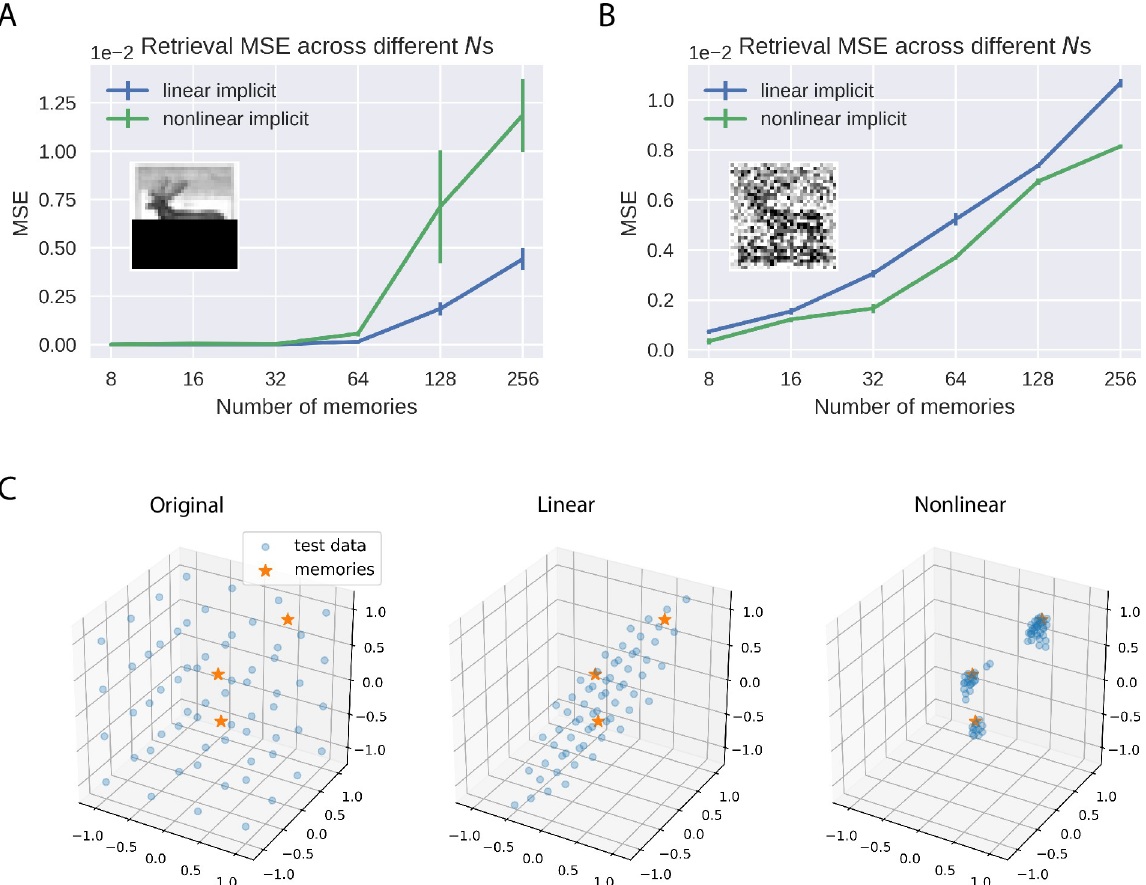
Fig 6. Comparison of linear and nonlinear implicit covPCN. A: Performance of linear and nonlinear implicit models in the completion task with varying N s. B: Same as A, but with the denoising task, where cues are memories with Gaussian noise of variance 0.1. C: A simple 3-dimensional example, where stars are data points the networks were trained to memorize. After training we ran inference on both linear and nonlinear models, initialized with grid test data drawn from the range [ − 1, 1] 3 . The position of the test data at convergence of inference indicates the shape of attractors. Images taken from the CIFAR10 dataset